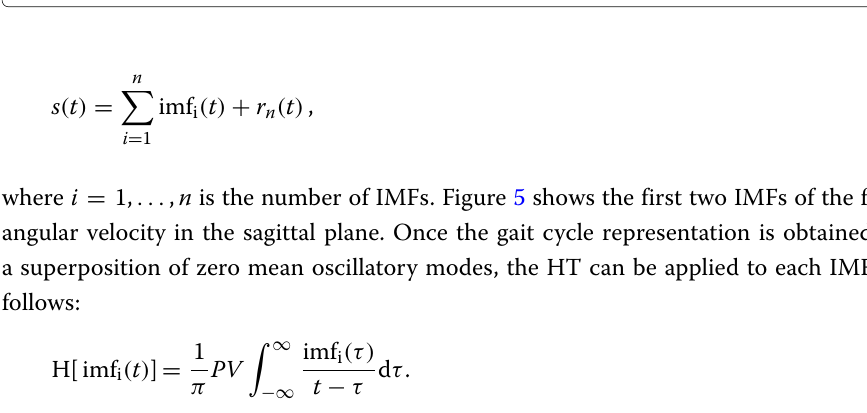
Fig. 5 IMF signal decomposition for the foot angular velocity in the sagittal plane which is used as input for the